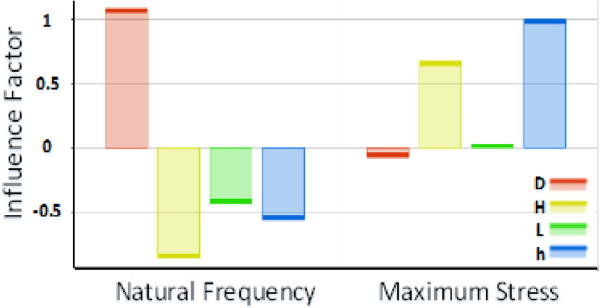
Fig. 8. The impact of parameters (H, h, R, L) on natural frequency and maximum stress on the cantilever